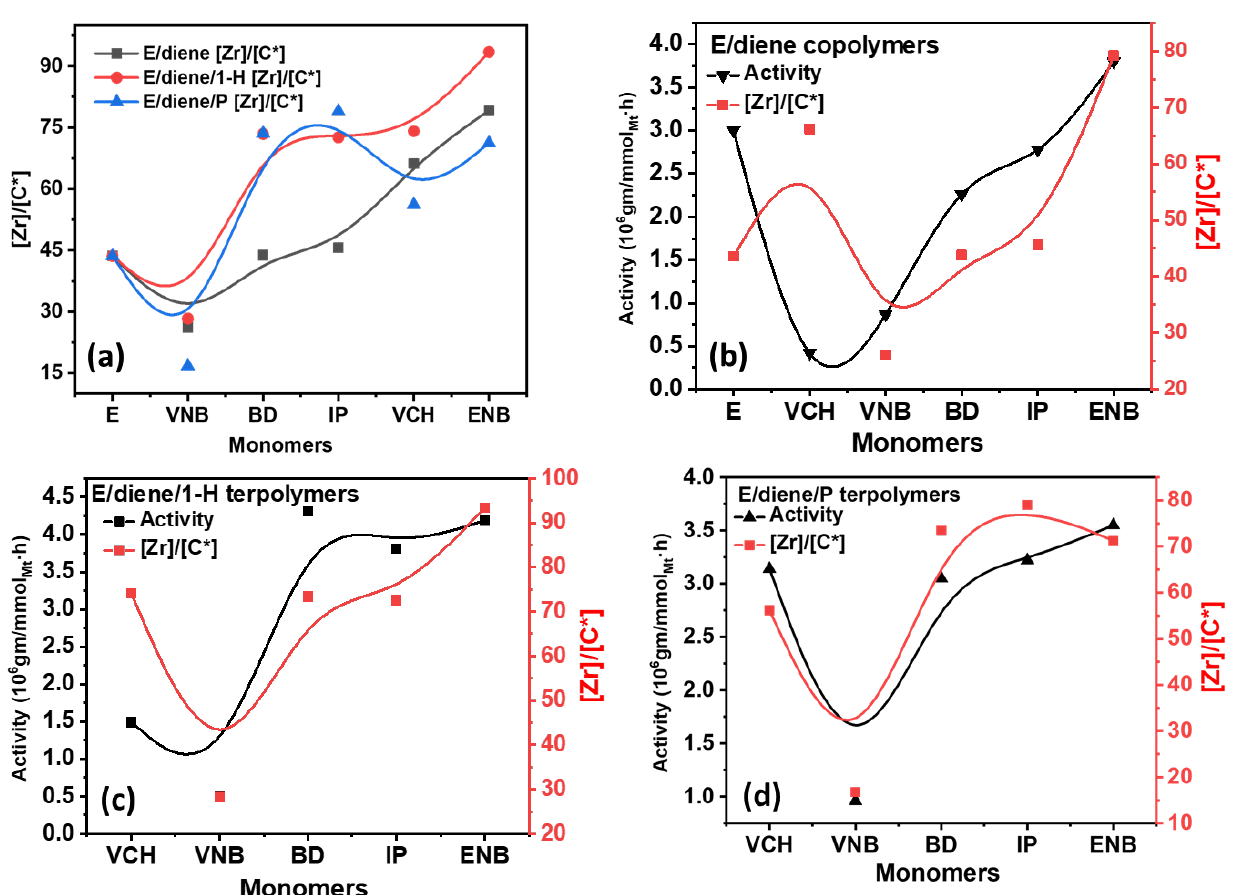
Figure 3. ( a ) Comparison of [Zr]/[C*] ratio between E/diene, E/diene/1-hexene and E/diene/P polymerizations, ( b – d ) are correlations between [Zr]/[C*] ratio and catalytic activities in E/diene, E/diene/1-hexene, and E/diene/propylene polymerizations, respectively. The catalytic [C*]/[Zr] active centers decreased when VCH diene was used in the E/diene copolymer. In contrast, in the presence of VNB, IP, BD, and ENB, the [Zr]/[C*] ratio continuously increased and reached the maximum level. Similarly, the [Zr]/[C*] active centers ratio in E/diene/propylene polymerization is higher than E/diene polymerization, but lower than E/diene/1-hexene polymerization. During the polymerization of isoprene and butadiene, notable stability was found compared to VCH and VNB. The highest [C*]/[Zr] ratio and catalytic activity were obtained with ENB with 1-hexene. In contrast, the catalytic activity and [C*]/[Zr] ratio decreased when VNB was used, which means that VNB was considerably involved in converting the active site of PE into dormant sites. However, overall the [Zr]/[C*] ratio and catalytic activity are higher in E/diene/1-hexene and E/diene/propylene polymers compared to E/diene copolymers and show that 1-hexene and propylene activate the dormant sites that were inactive during the E/diene copolymerizations. 1 HNMR spectroscopy is a powerful and sensitive technique used to determine the microstructure and composition of the polymer. The E/diene, E/diene/1-hexene, and E/diene/propylene polymerization microstructures are illustrated in Supporting Information in Figures S1, S2, and S3, respectively. In addition, Figure 4 shows the plot of E mol% in the co- and terpolymers against the active catalyst ratio.